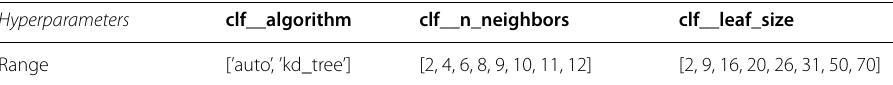
Table 12 Hyperparameters optimized for